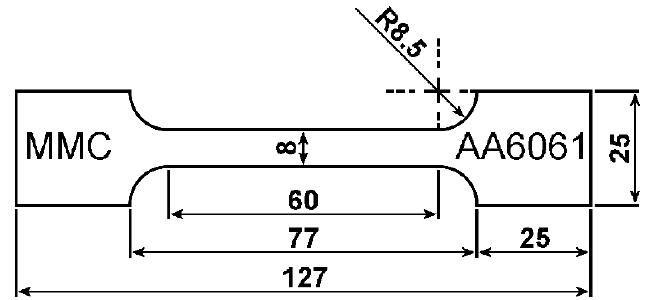
Figure 1. Dimensions (in mm) of tensile test specimens machined from the welded samples.